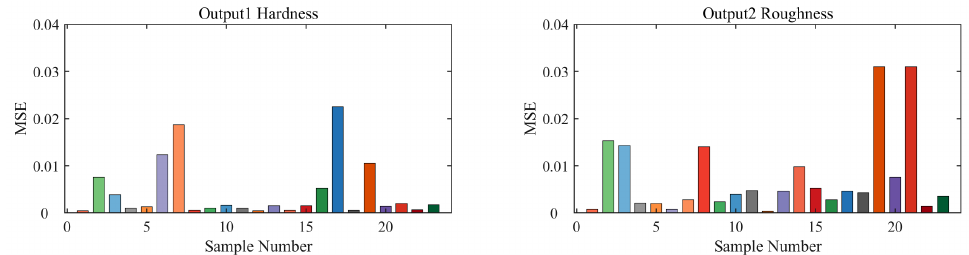
Figure 7. The Hardness and Roughness MSE for each of the twenty-three samples.